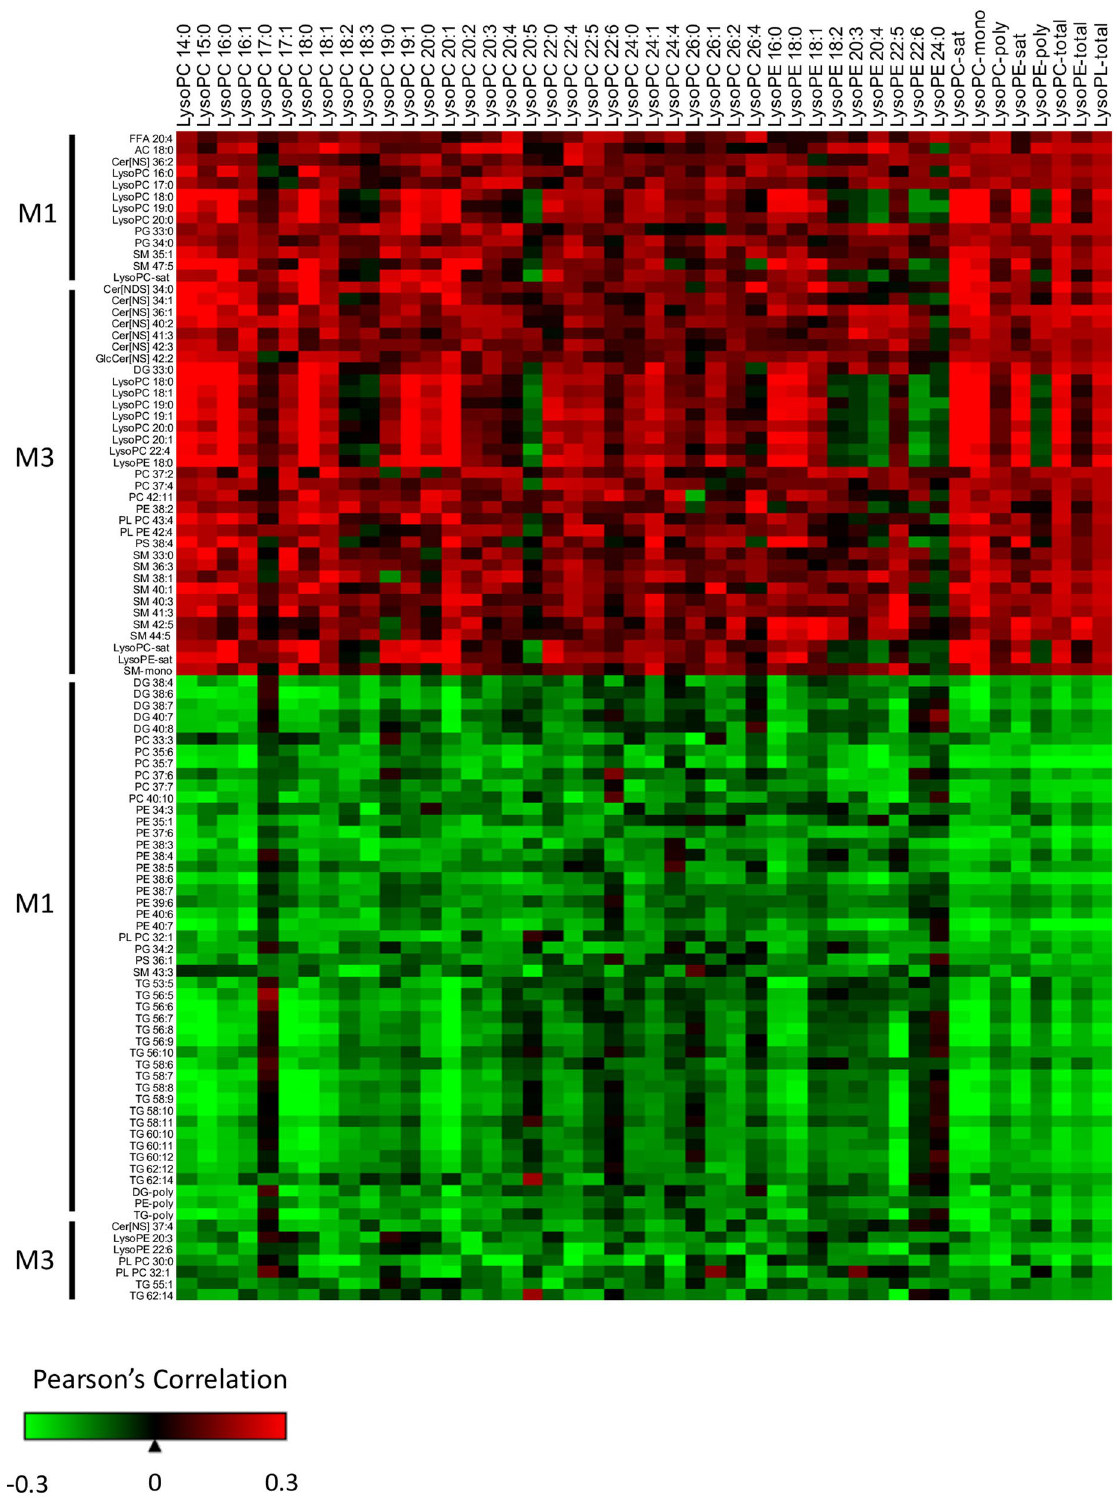
Figure 6. Maternal lipids correlate with cord blood lysophospholipids. The association between maternal individual lipids and lipid groups with CB LysoPCs, LysoPEs, and total LysoPLs was classified using Pearson’s correlations. Maternal lipids listed were significantly correlated with the lipid group CB LysoPL-total (unadjusted p-value α = 0.05). Maternal lipids (rows) are broken down by positive and inverse associations. Cord blood lysophospholipids (columns) are ordered by increasing chain length and number of double bonds. CB lipids groups LysoPC-sat, LysoPC-mono, LysoPC-poly, LysoPE-sat, LysoPE-poly, LysoPC-total, LysoPE-total, and LysoPL-total are listed in the last